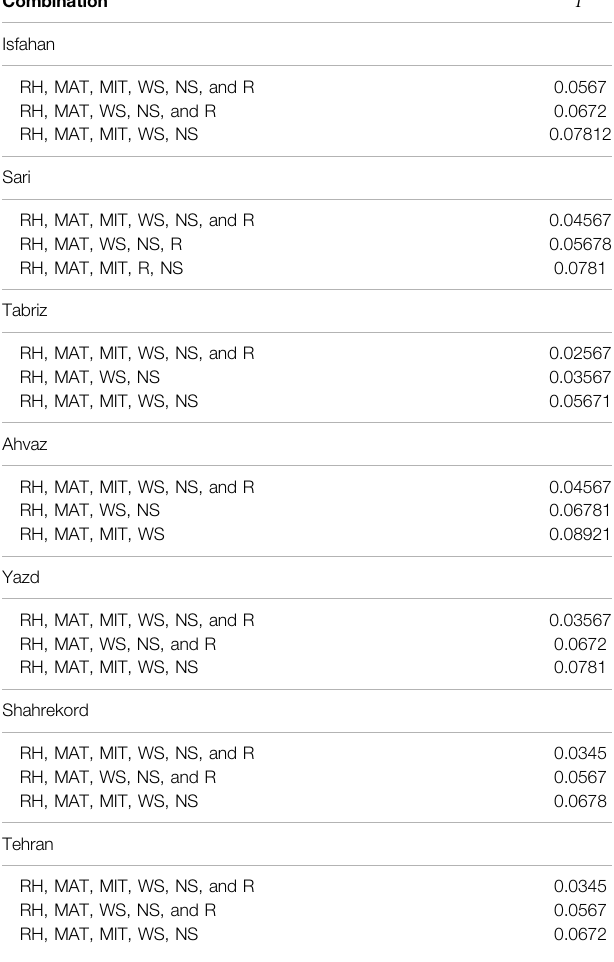
Table 3 indicates the fi rst-best input scenario to the third-best input scenario for all stations. As observed in Table 4 , MAT, MIT,